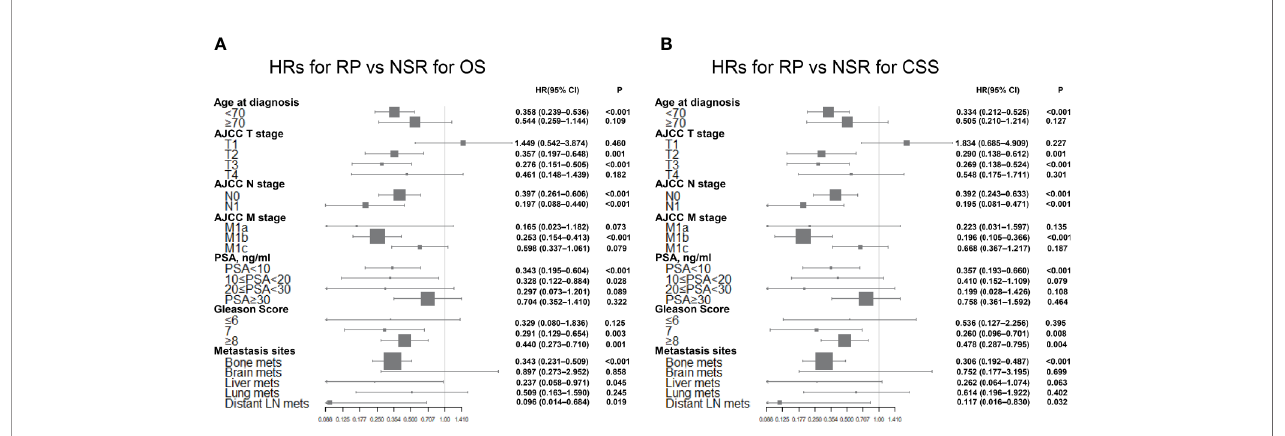
FIGURE 4 | Forest plots summarizing the HRs and 95% CIs of (A) overall and (B) cancer-speci fi c survival for RP versus NSR in